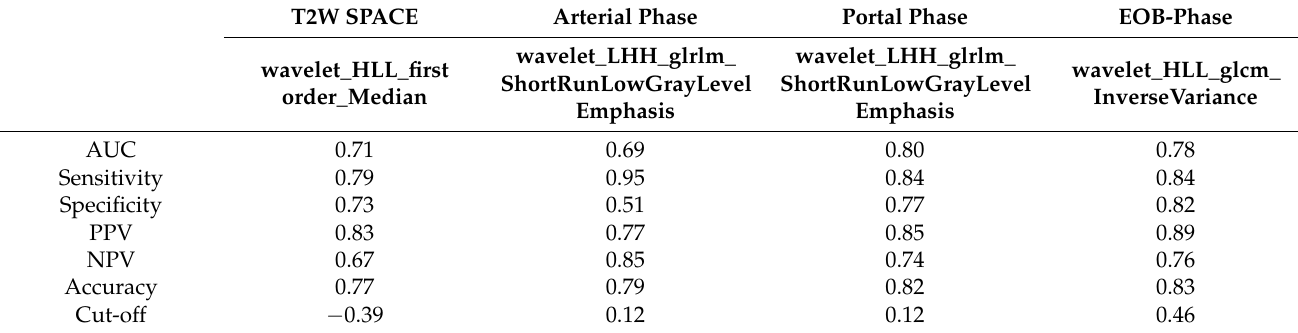
Table 3. Univariate analysis results to predict mucinous type.